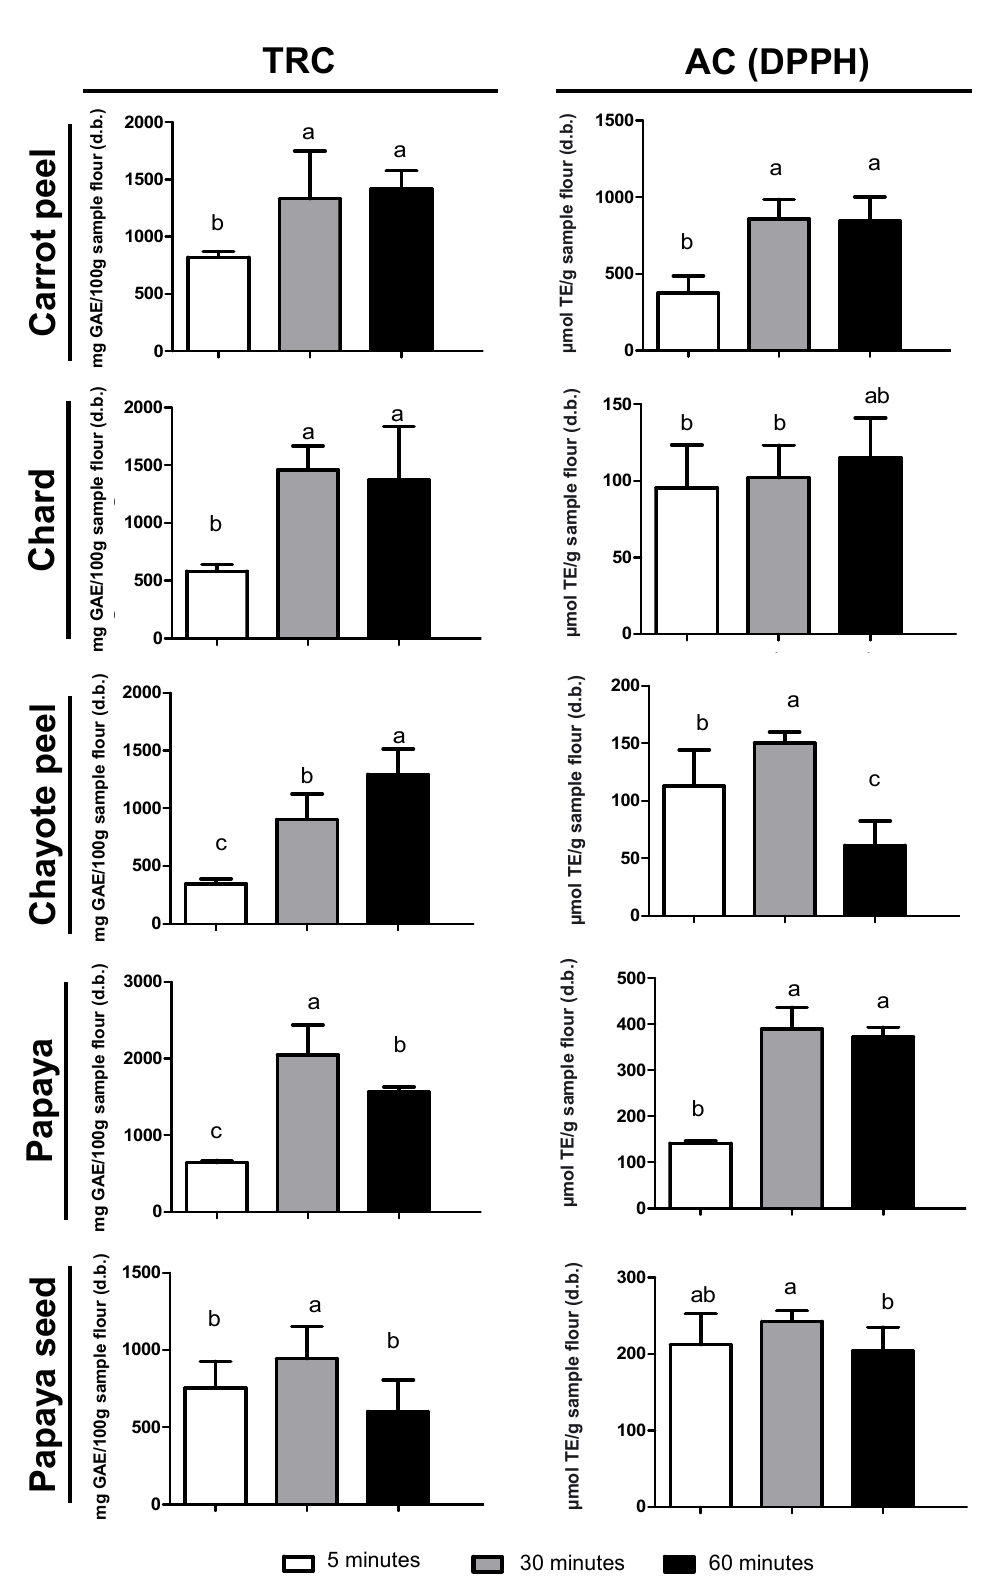
Figure 2. Evaluation of ultrasonication (US) extraction for 3 different times in terms of total reducing capacity (TRC) and antioxidant capacity (AC) by the DPPH method on five fruit and vegetable by-products (FVB). Results are expressed as mean ± standard deviation ( n = 3). Different letters indicate a significant difference between US time (Tukey, p < 0.05).